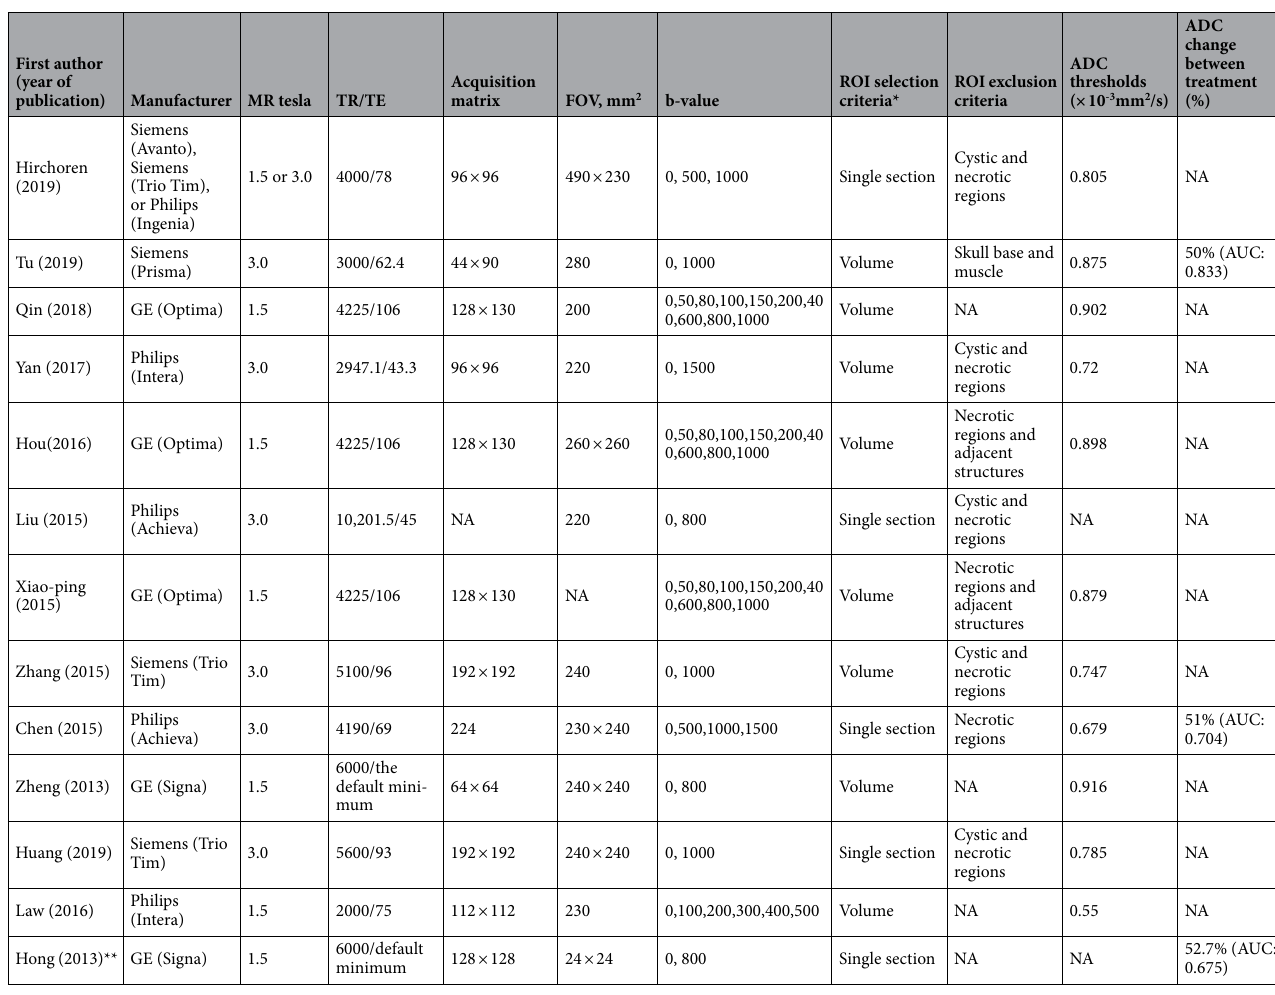
Table 2. MRI characteristics of the included studies. NA, not applicable; ROI, region of interest; ADC, apparent diffusion coefficient; FOV, field of view; AUC, area under the curve for predicting treatment response. *Single section = the ROI was drawn at the largest cross-sectional area of the tumor; Volume = the mean of all ADC values obtained from all sections involving tumor. **Not included in quantitative data